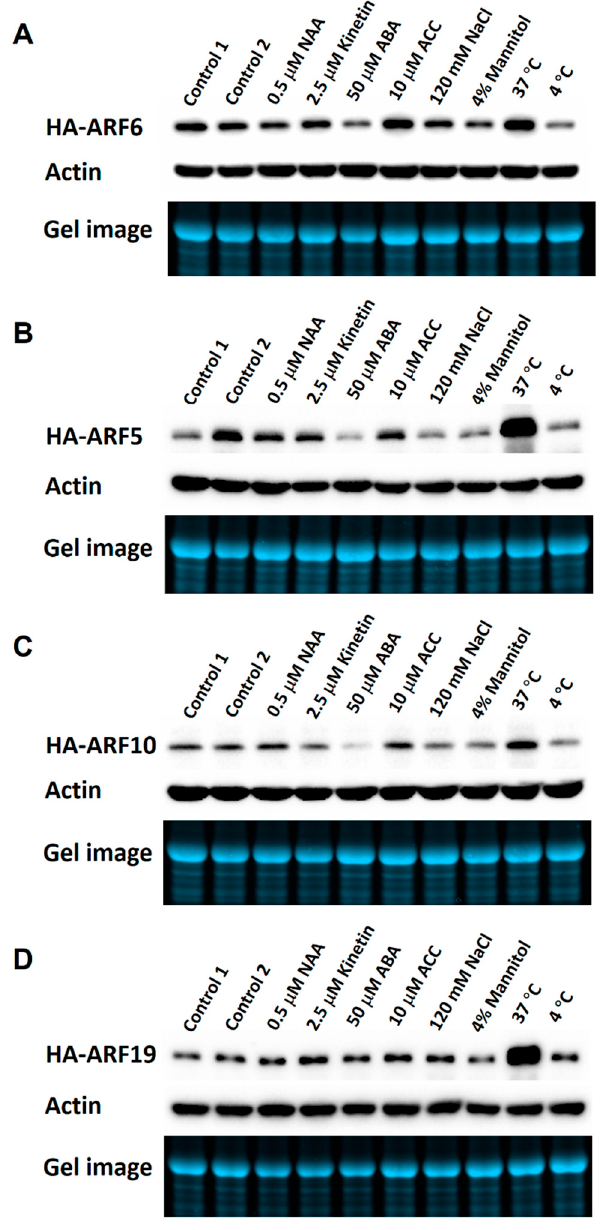
Figure 2. Effects of different treatments on protein expression of HA-ARF6 ( A ), HA-ARF5 ( B ), HA-ARF10 ( C ), and HA-ARF19 ( D ). Stable transgenic HA-ARF lines (T2 or later generation) were used. Seedlings were grown vertically in Petri plates. At 10 to 11-day stage they were transferred to treatment plates containing a piece of filter paper and 5 mL half-strength MS with or without a treatment reagent, with each plate having about 25 seedlings. After the treatment, protein samples were prepared and used (30 µ g per lane) for electrophoresis in the Bio-Rad TGX mini-gel, followed by western blotting. In each subfigure, the first row shows the western blot with an anti-HA antibody. For loading controls, the second row shows the western blot with an anti-actin antibody and third row shows the gel image. The treatment conditions are indicated above the lanes. Control 1: half MS medium; Control 2: half MS medium plus 0.1% ethanol (since NAA, kinetin, ABA were added from ethanol stocks); ACC: 1-aminocyclopropane-1-carboxylic